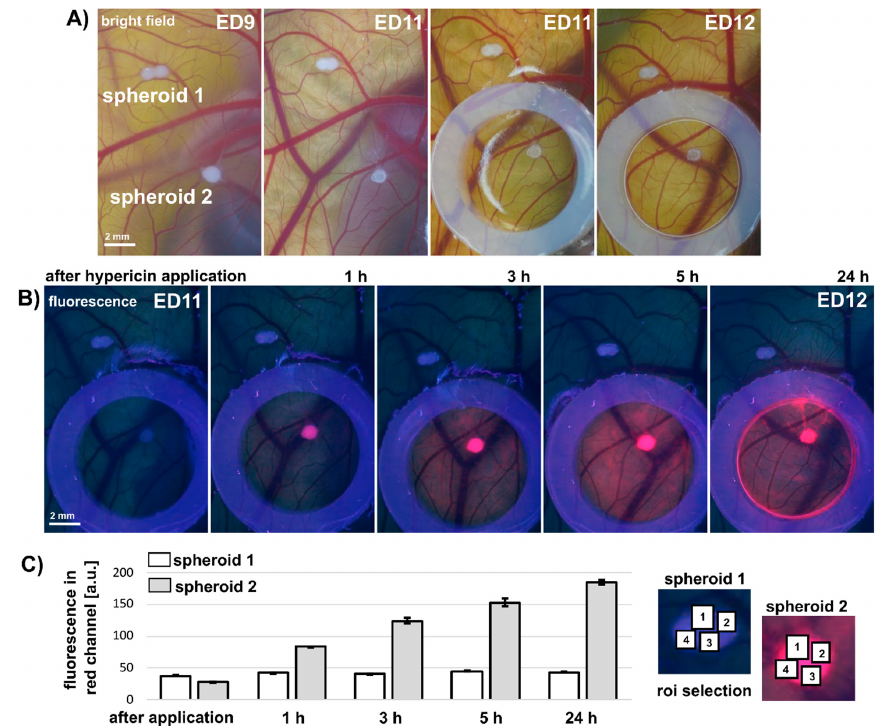
Figure 8. ( A ) Representative color images of quail CAM with U87MG spheroids detection right after and 1–3 days after the implantation. Silicon ring and hypericin was applied at 2nd day after spheroids implantation. Scale bar represents 2 mm. ( B ) Fluorescence of 10 µM hypericin (pink) detected in spheroid 2 right after and 1, 3, 5 and 24 h after hypericin administration. Scale bar represents 2 mm. ( C ) Fluorescence intensity detected in four spots (as illustrated in right) of spheroid 1 and 2 from red channel of RGB images. The error bars represent the standard deviation of the measurements. Experiment was repeated at least four times.